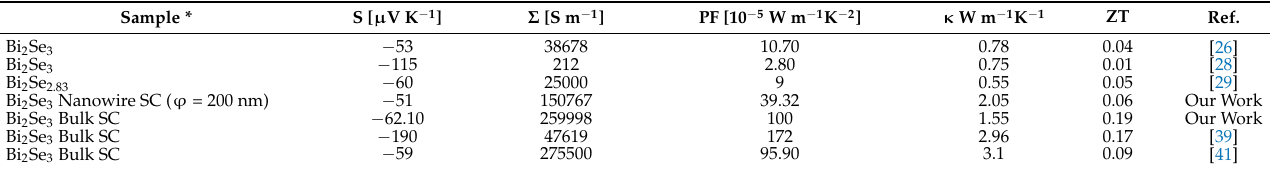
Figure 6. ( a ) Thermal conductivity κ , and ( b ) figure of merit ZT values of Bi 2 Se 3 NW in the temperature range of 290 K to 320 K. Table 1. The transport properties of Bi 2 Se 3 nanowire and bulk at room